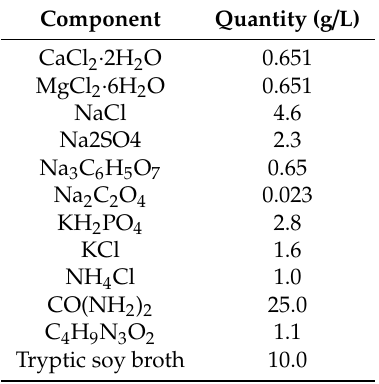
Table 1. Artificial urine composition